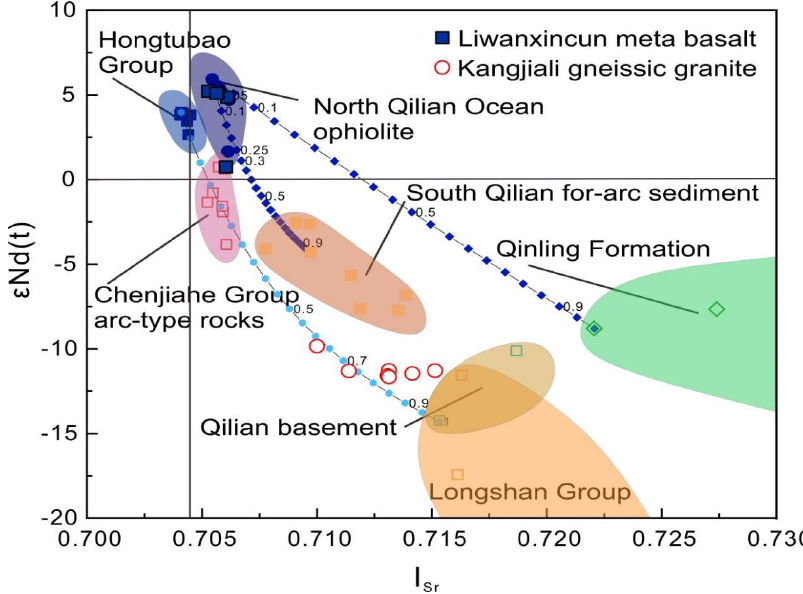
Figure 15. ε Nd(t) versus I Sr diagram of the Kangjiali gneissic granite and the Liwanxincun metabasalt. The initial isotopic composition data are calculated at t = 443.8 Ma according to the U-Pb age of Changgouhe dioritic gneiss [39]. Data sources: North Qilian Ocean ophiolites from Hou et al. (2006) [40]; Hongtubao MORB-type basalts from Hu. (2005) [41]; Chenjiahe Group arc-type rocks from Hu (2005) [41]; South Qilian for-arc sediment from Tao et al. (2018) [42]; granite gneiss in Qinling Formation from Liu et al. (2013) [43]; granitoids in the Qilian basement from Huang et al. (2015) [37] and Xu (2007) [44].